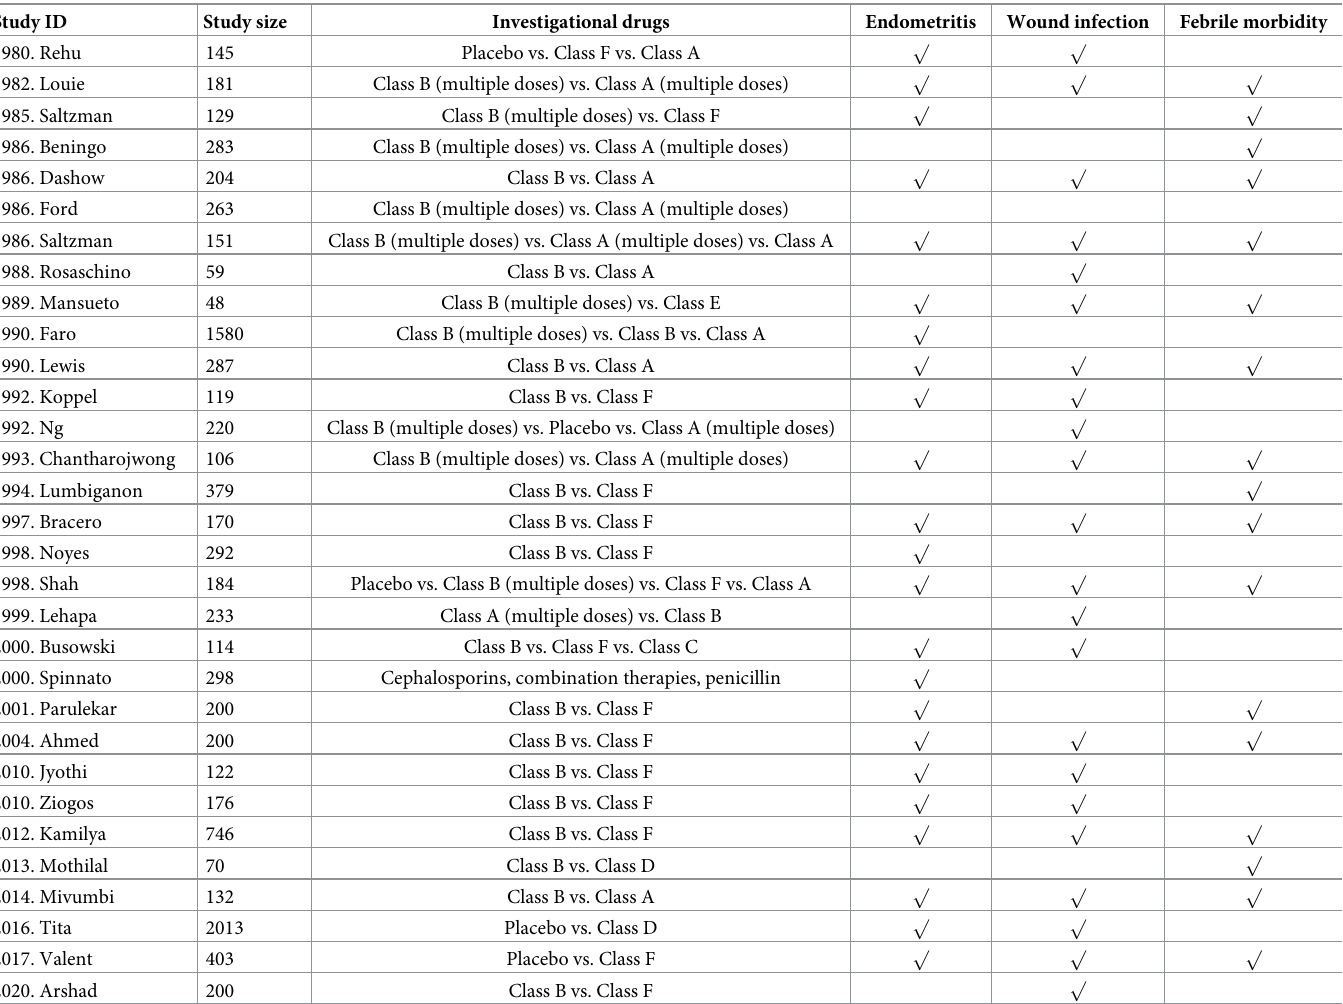
Table 1. Characteristics of the included